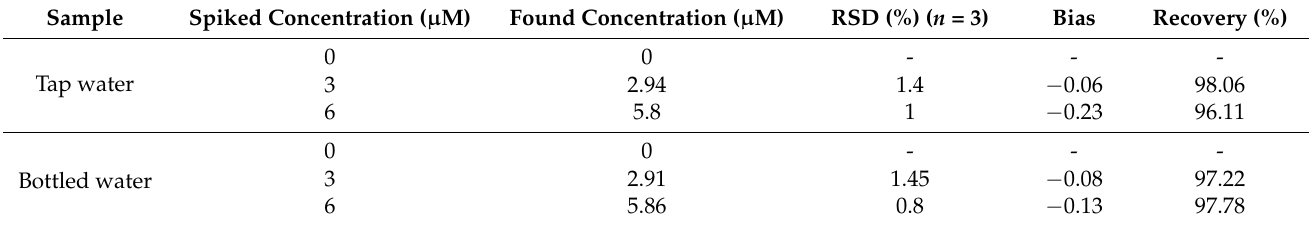
Table 2. Data obtained for the determination of zinc ions in real samples using the proposed (LSV) method. Sample